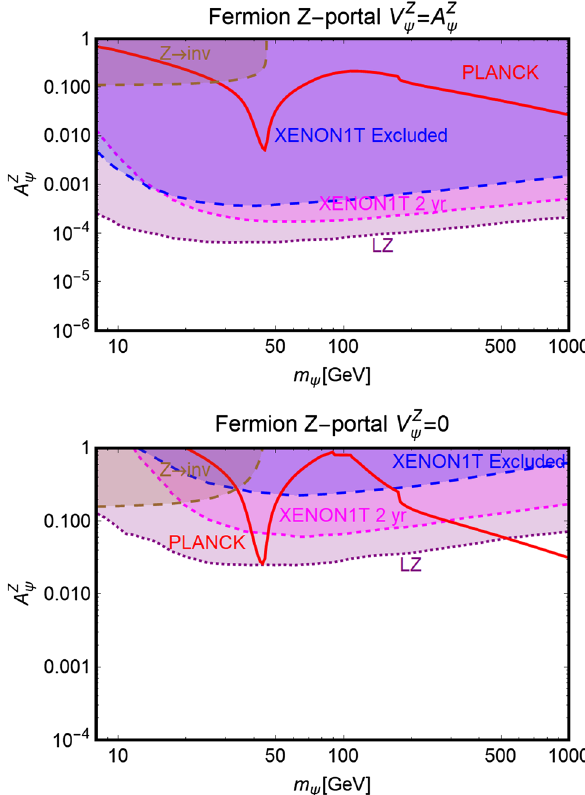
Fig. 7 The same as Fig. 6 but for Dirac fermion DM in the relevant bi-dimensional plane m ψ - A Z ψ with both vectorial and axial couplings (top panel), set to the same value, and only axial couplings (bottom panel) with the Z